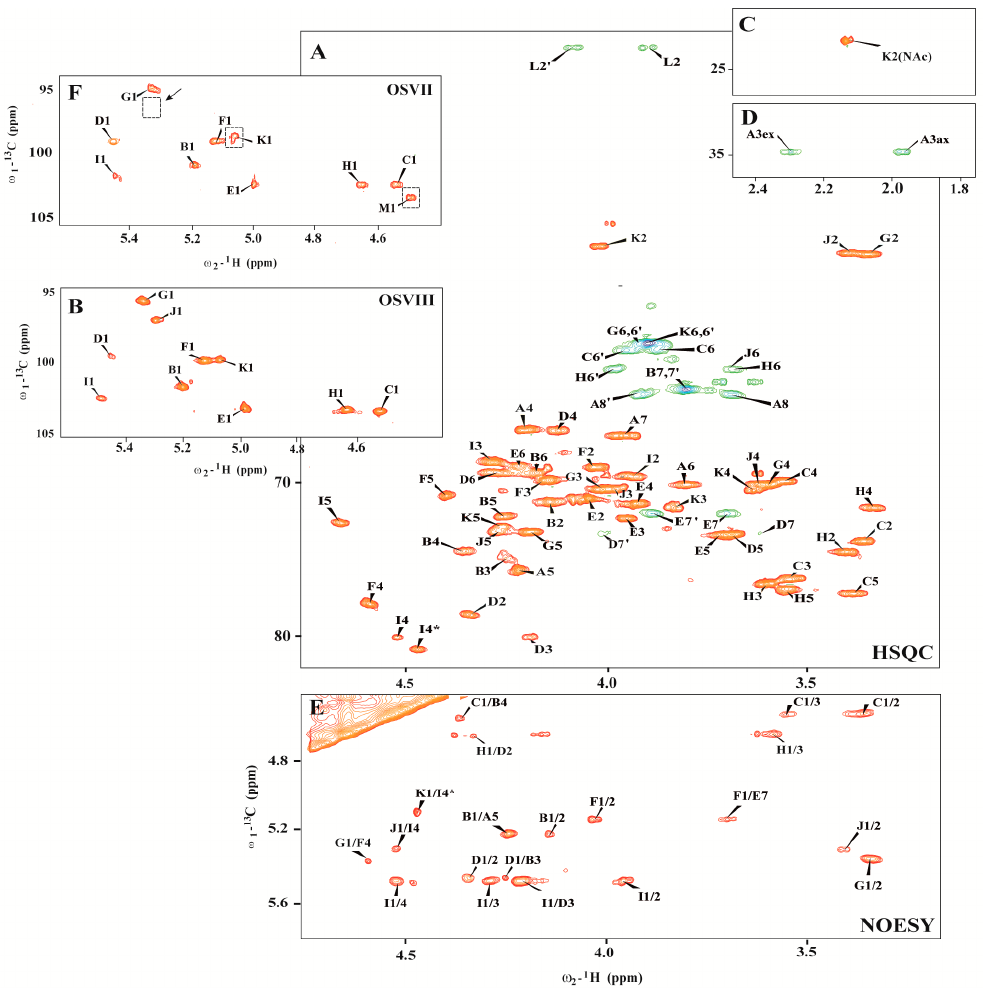
Figure 1. ( A – D ) Selected regions of the 1 H– 13 C HSQC-DEPT (heteronuclear single-quantum correlation–distortionless enhancement by polarization transfer) and ( E ) 1 H– 1 H NOESY (nuclear overhauser spectroscopy) spectra of the fraction OSVIII of Edwardsiella tarda EIB 202 lipopolysaccharide (LPS); ( F ) anomeric region of the 1 H– 13 C HSQC-DEPT spectrum of the fraction OSVII with marked difference in comparison with OSVIII. The cross-peaks are labeled as shown in the text.